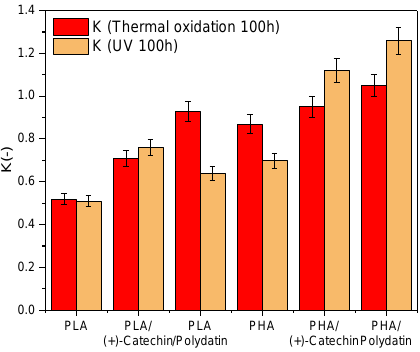
Figure 2. The aging coefficient (K) of PLA and PHA with polydatin and (+)-catechin after thermal oxidation and UV aging. Resistance to degradation of samples: K = 1 resistant and K = 0 susceptible.